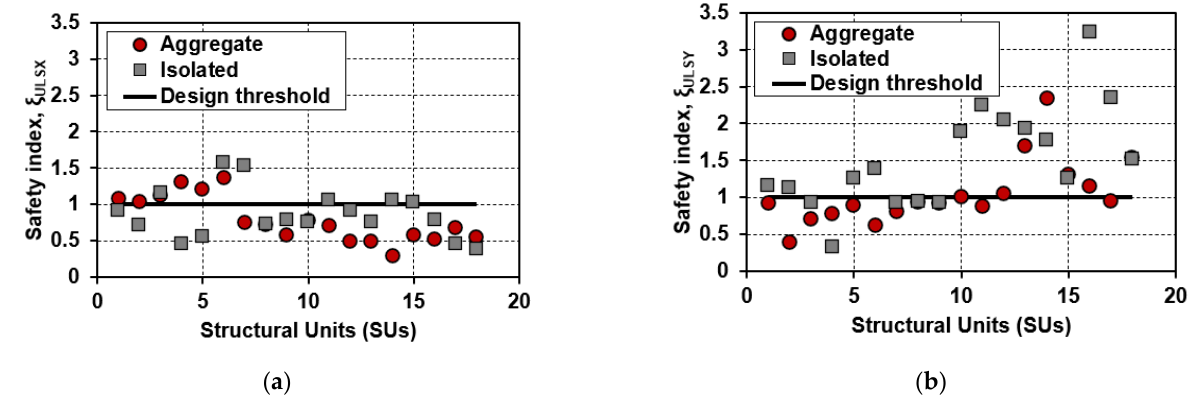
Figure 11. Seismic risk index , ζ , evaluated for all structural configurations in X ( a ) and Y ( b ) analysis directions.